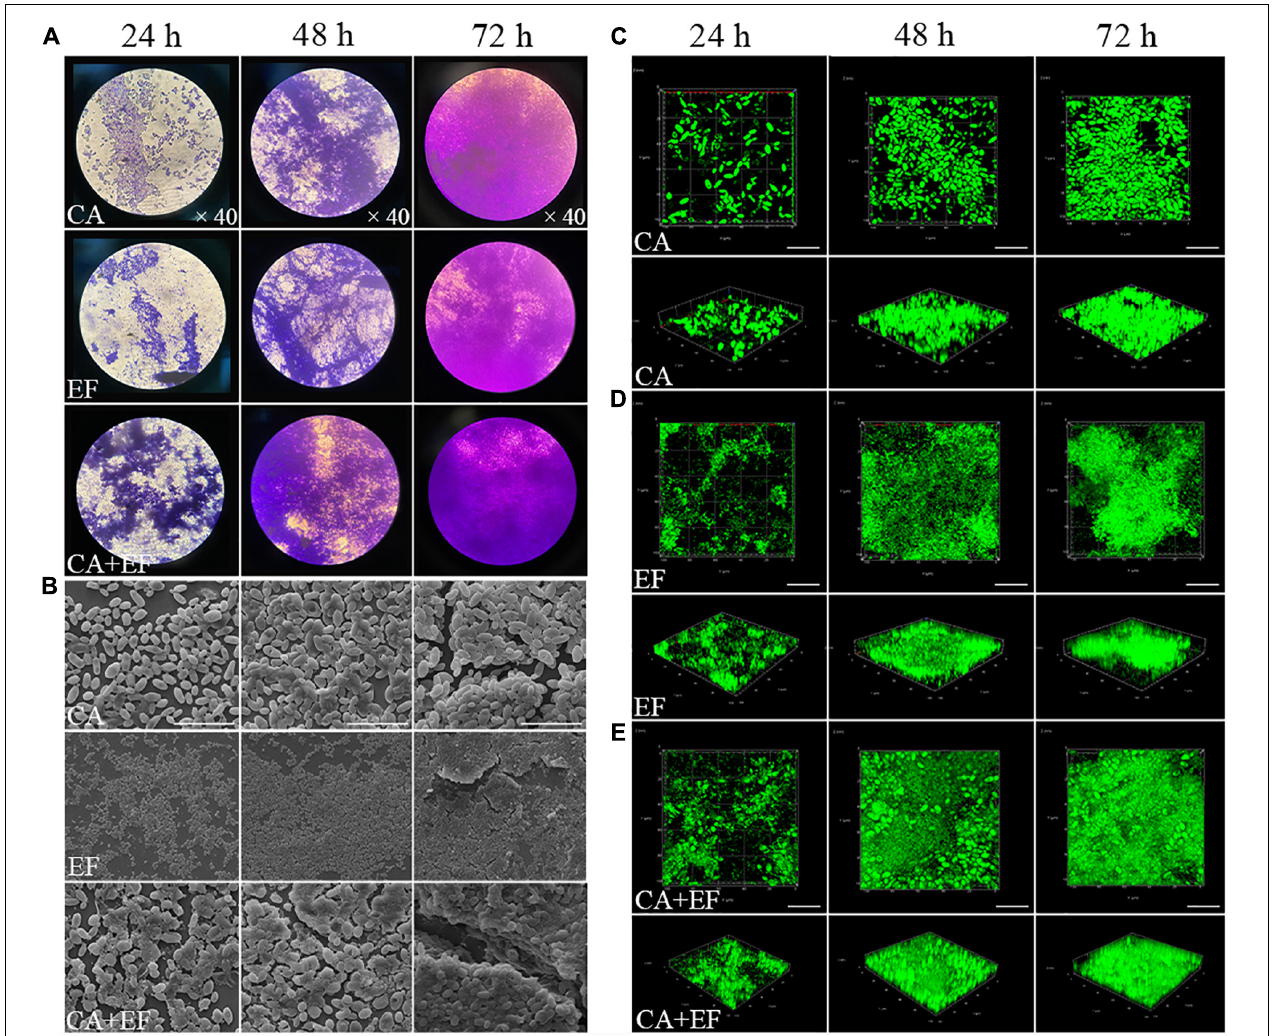
FIGURE 1 | The biofilm structure of C. albicans SC5314 (CA) and E. faecalis 20033 (EF) single and dual species (CA + EF) at different cultivation times (24, 48, and 72 h) was assessed by crystal violet staining assay (CVSA) (A) , field emission scanning electron microscope (FESEM) (B) (magnification × 5,000), and confocal laser scanning microscope (CLSM) (C–E) . Scale bars represent 20 µ m for